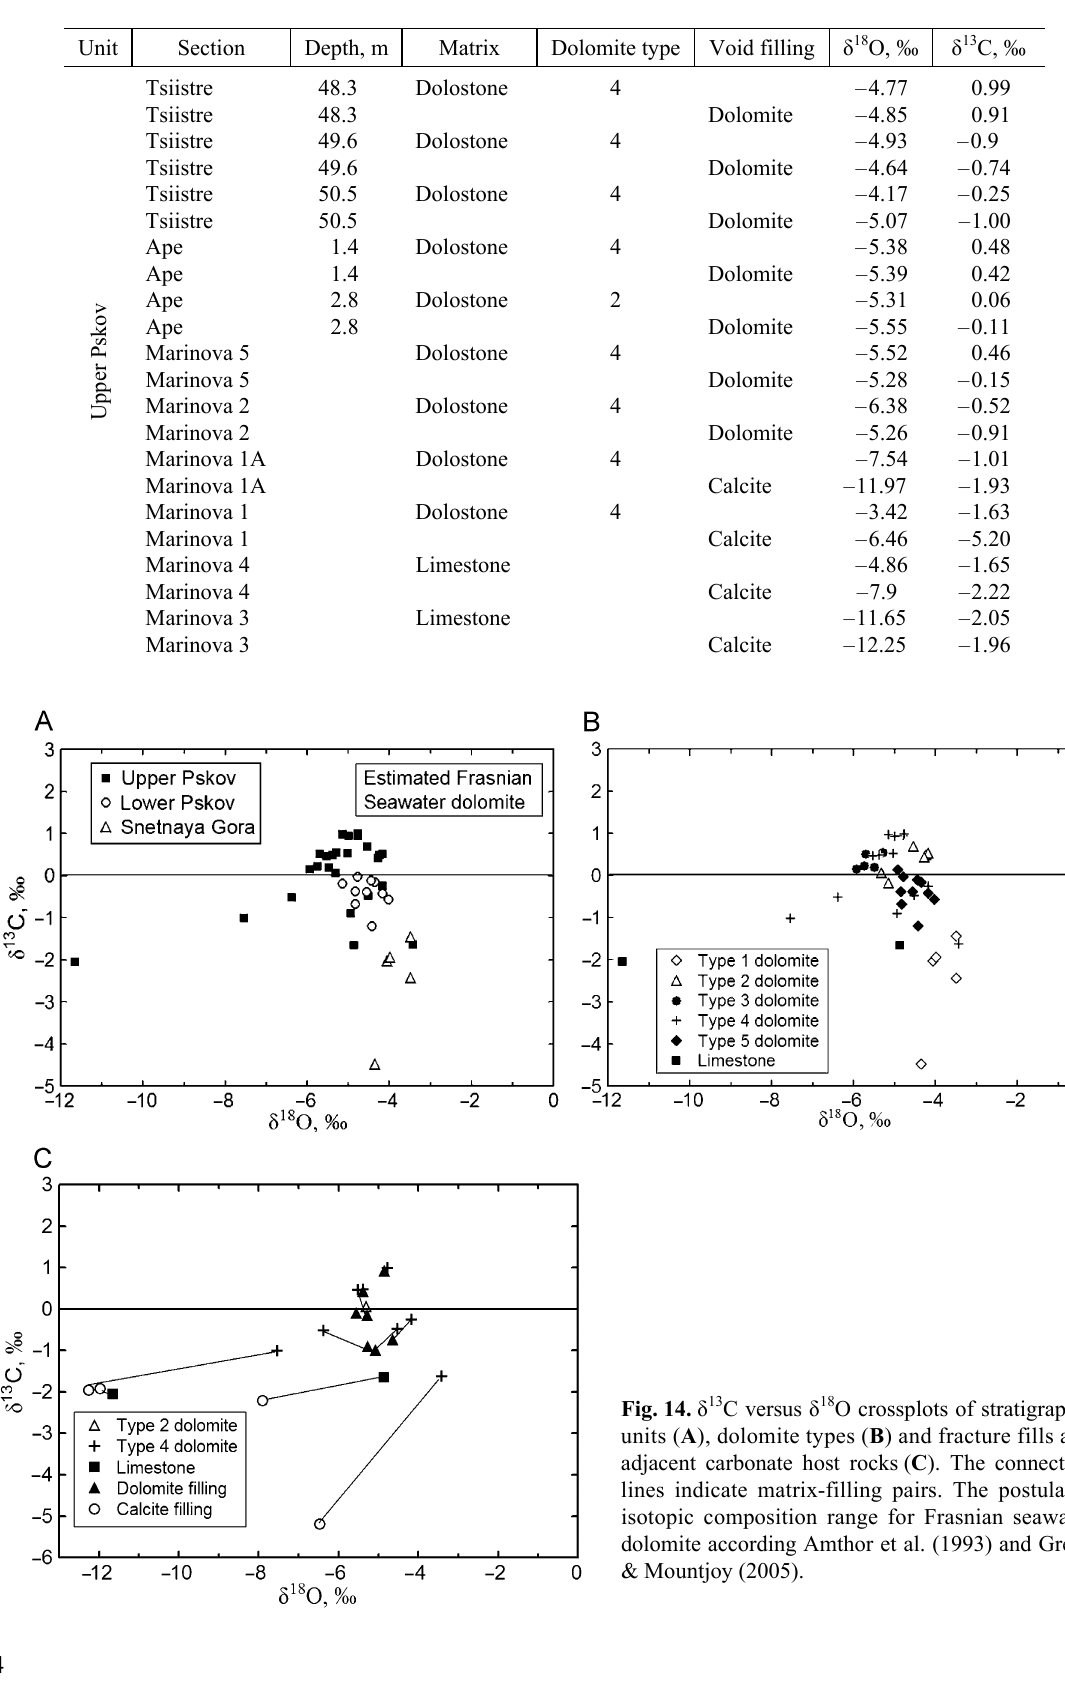
Table 4. Carbon and oxygen isotope data of void-filling carbonate and host rock